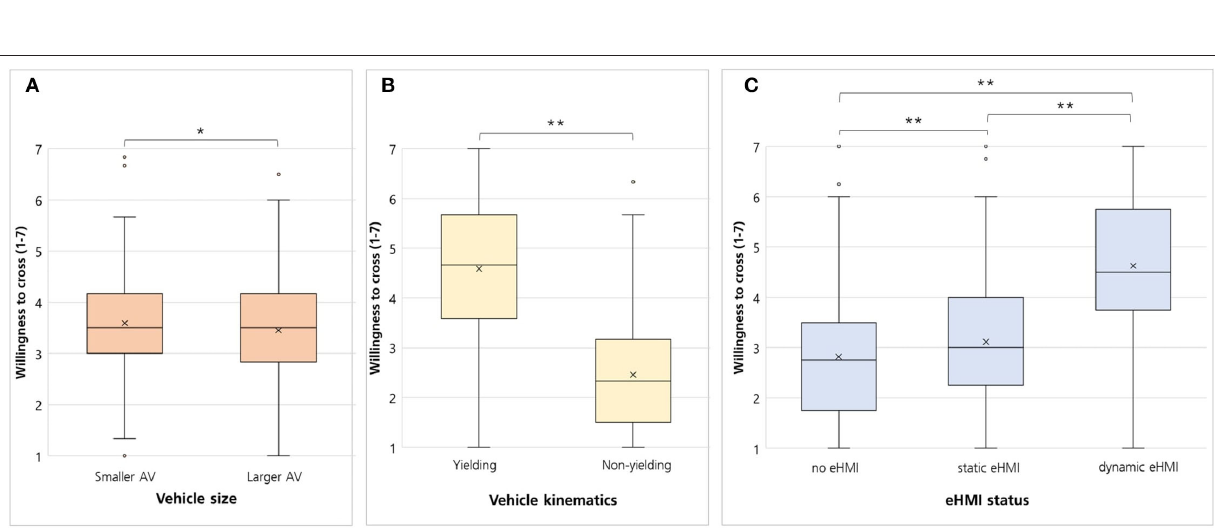
Secondly, there were significant correlations between pedestrians’ willingness to cross and the perceived support of the eHMI for both AVs when the vehicle yielded and was equipped with dynamic eHMI (smaller AV: r = 0.53, p < 0.001; larger AV: r = 0.5, p < 0.001). When the vehicle did not yield but the dynamic eHMI indicated so, pedestrians’ willingness to cross still highly correlated with the perceived support of the eHMI (smaller AV: r = 0.81, p < 0.001; larger AV: r = 0.73, p < 0.001). No correlations were found between pedestrians’ willingness to cross and the perceived support of a static eHMI for both AVs ( p >